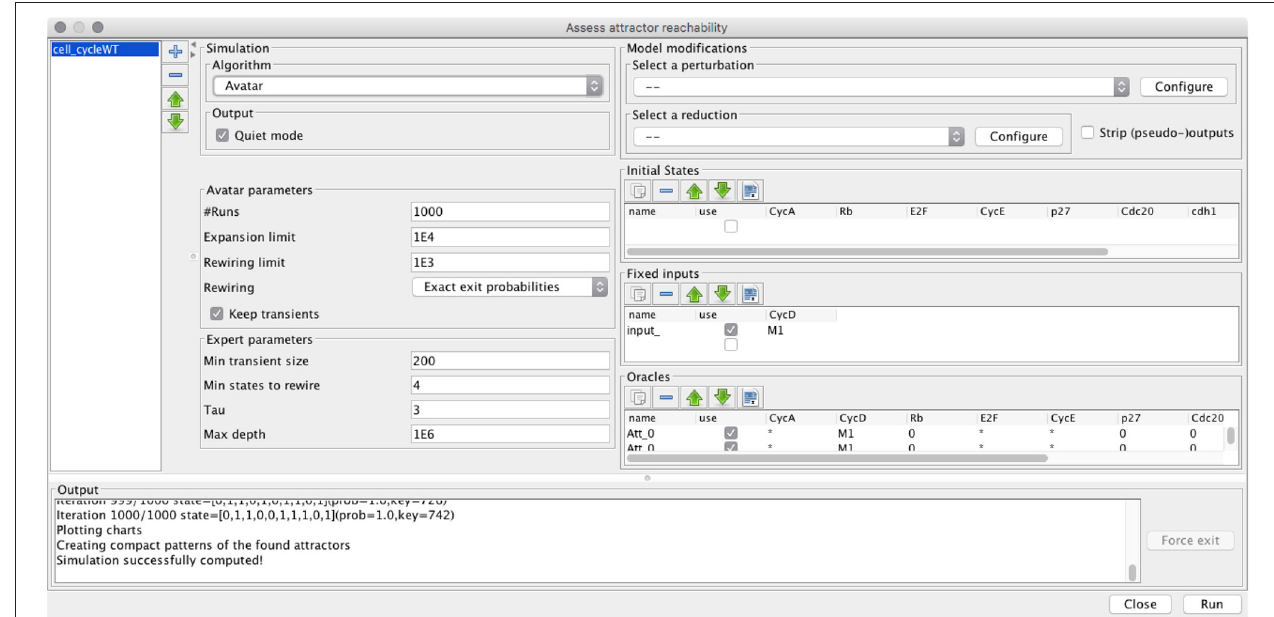
FIGURE 3 | GUI for the assessment of attractor reachability within GINSIM